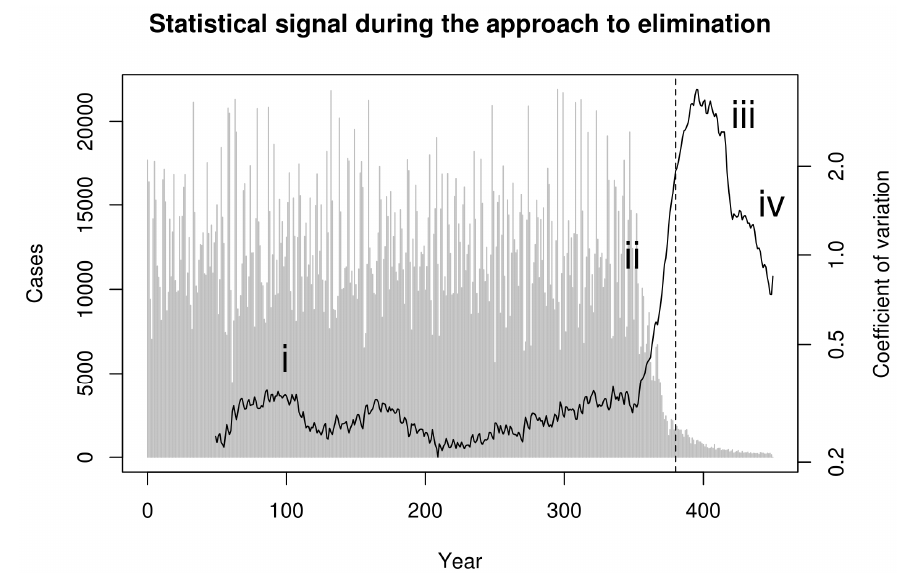
Figure 2. Statistical signal of the approach to the vaccination thresholds in simulated smallpox elimination. Contagion systems exhibit critical slowing down in the approach to a tipping point such as the vaccination threshold. The coefficient of variation in a moving window provides a measurement of the magnitude of this slowing down. We calculated this statistical signature by first detrending with a one-sided filter and then computing the coefficient of variation in a moving window of 30 observations. This figure shows this statistical signal to begin increasing with the onset of vaccination and to rise dramatically as the approach to the vaccination threshold (vertical dashed line) is approached.